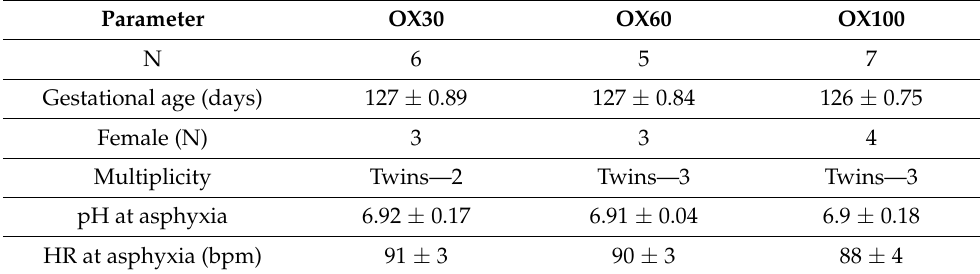
Table 1. Characteristics of preterm lambs.